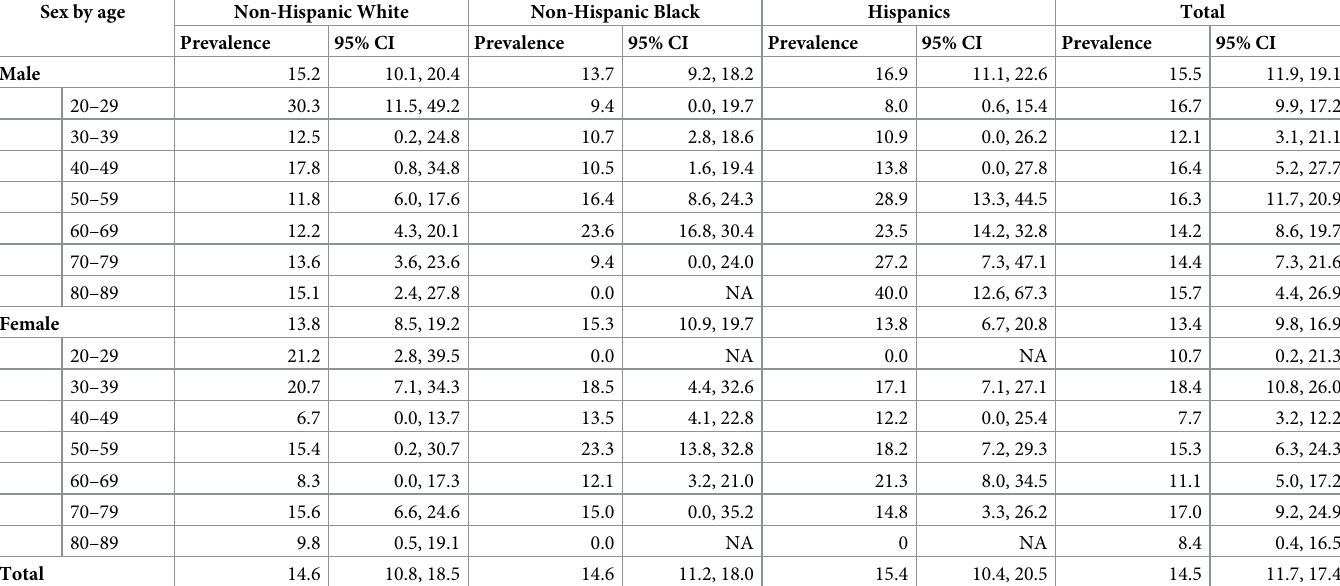
Table 5. Weighted prevalence of significant NAFLD fibrosis (F2, F3 and F4) by age group, sex and race/ethnicity. Sex by